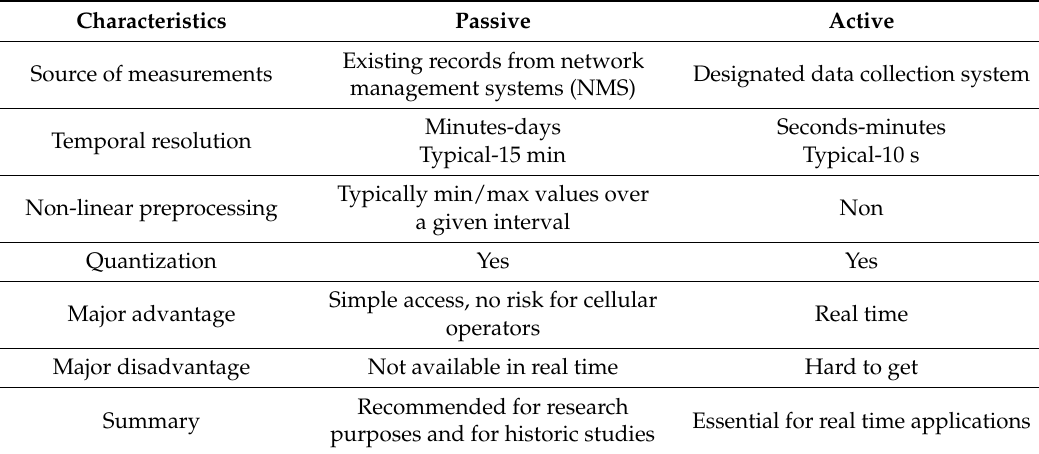
Table 1. Available commercial microwave link (CML)